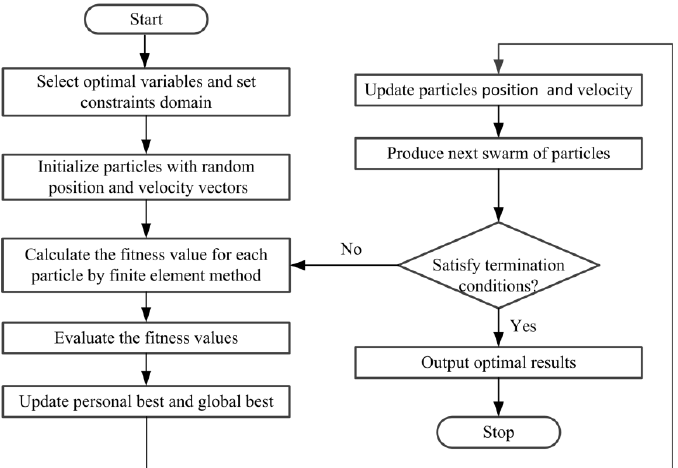
Figure 5. Flow chart of optimization design using